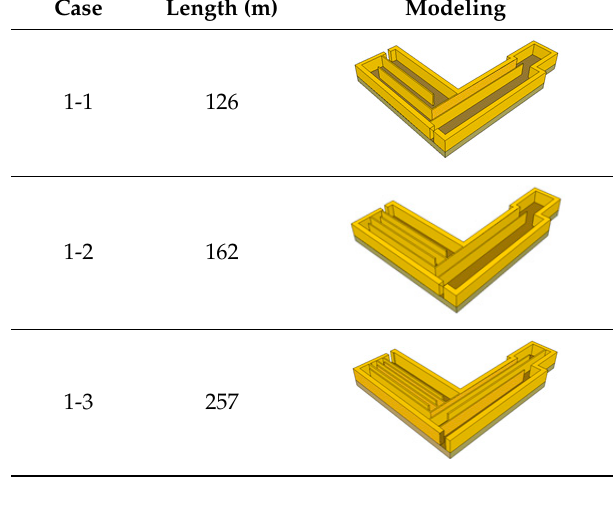
Table 7. The studied cases for analyzing the impact of the change in the length on the heat transfer efficiency.